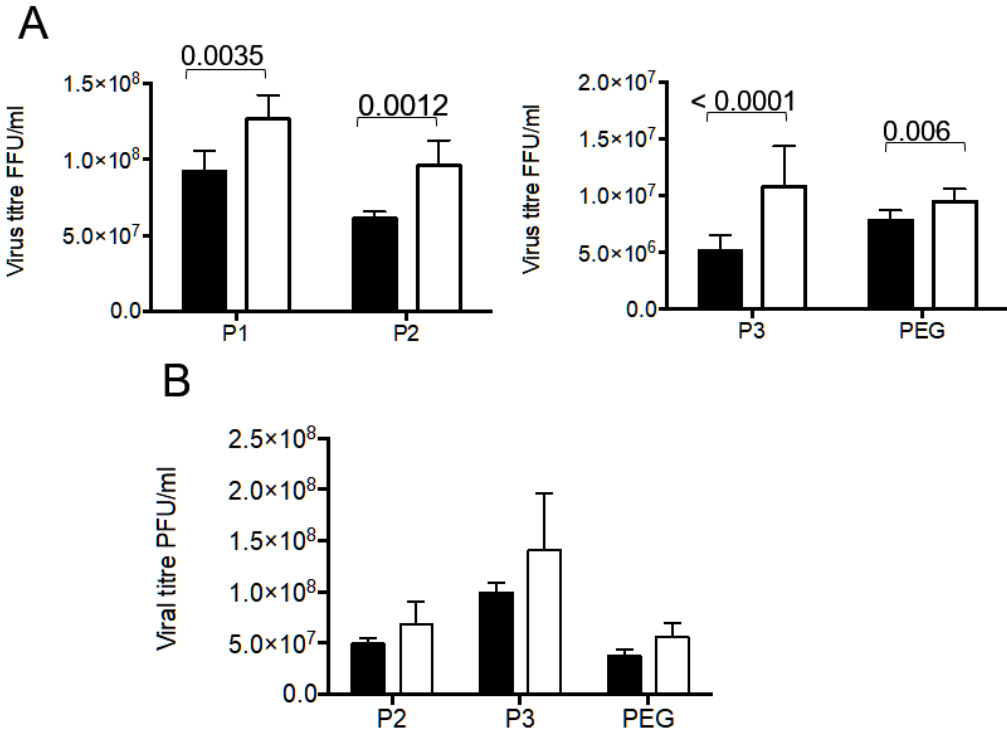
Figure 3. A fraction of the viral particles associated with secreted extracellular vesicles in MA104 and Caco-2 cells is protected from trypsin activation. MA104 and Caco-2 cells grown to confluence were infected with the RRV strain, for 10 or 18 h, respectively, the time at which the cell culture supernatant was collected. Di ff erent fractions were collected as described in material and methods, P1 by centrifugation at 500 × g , P2 at 2000 × g , P3 at 9600 × g and PEG, by precipitation with PEG6000. All fractions were resuspended in TNC, and further processed using MEM without FBS. The infectious virus present were titrated by a standard focus forming assay, with all fractions being either treated or not with detergent (Triton X-100 0.1%) for 30 min at 37 ◦ C before trypsin activation. ( A ) Viral titer associated with fractions purified from Caco-2 cells. ( B ) Viral titer associated with fractions purified from MA104 cells. The results are expressed as titer of infectious virus in the corresponding fraction without (full bars) or with (open bars) detergent treatment previous to trypsin activation. The results are expressed as the average and standard deviation of at least five independent experiments. Statistically significant values are shown above corresponding